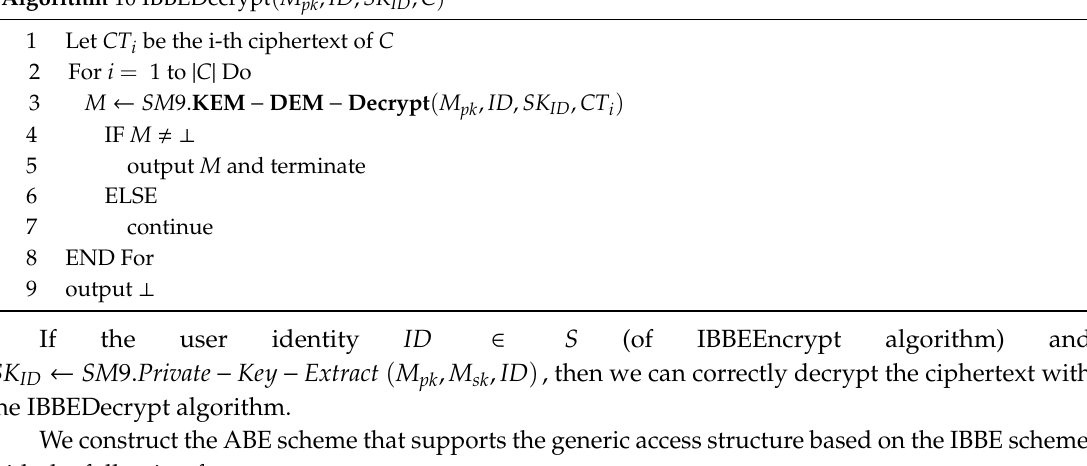
Algorithm 10 IBBEDecrypt ( M pk , ID , SK ID , C